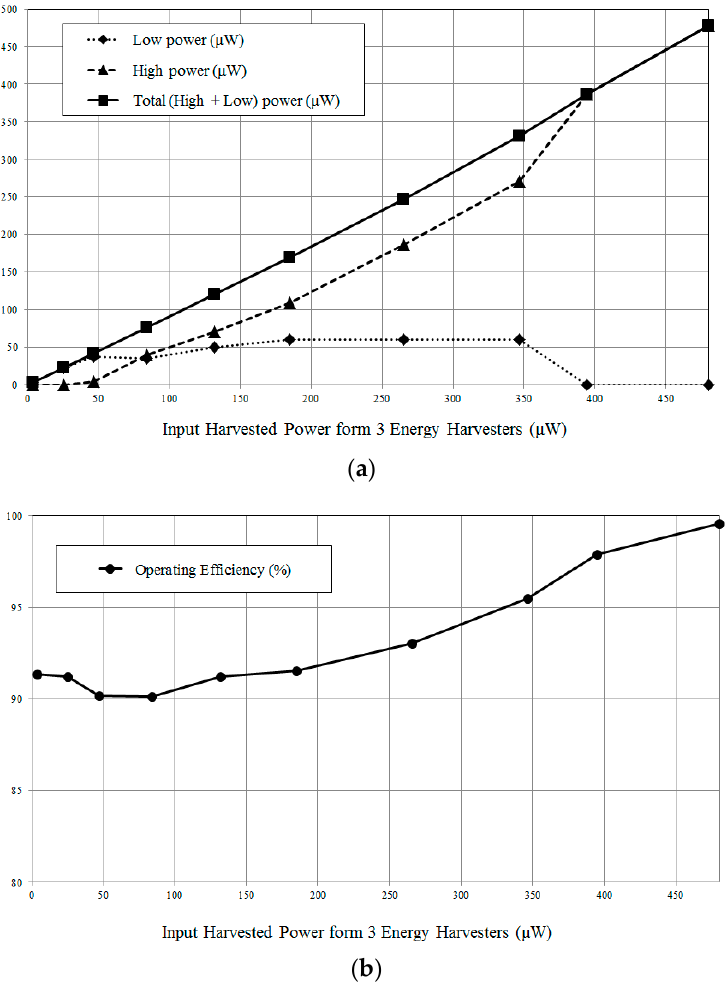
Figure 11. Measured graphs for the newly developed IC. ( a ) measured-output flow as the magnitude of power; ( b ) operating efficiency as the magnitude of power.